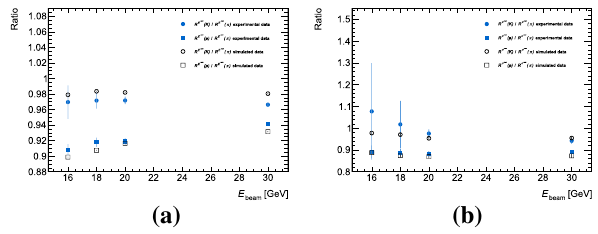
Fig. 22 a Ratios of the kaon and proton responses over those from the pions as a function of E beam . The blue circles (black empty circles) show the ratios R (cid:6) E raw (cid:7) ( K )/ R (cid:6) E raw (cid:7) (π) obtained using experimental (simulated) data. The blue full (black empty) squares show the ratios R (cid:6) E raw (cid:7) ( p )/ R (cid:6) E raw (cid:7) (π) obtained using experimental (simulated) data. b Ratios of the kaon and proton resolutions over those from the pion as a function of E beam . The blue cicles (black empty circles) show the ratios R σ raw ( K )/ R σ raw (π) obtained using experimental (simulated) data. The blue full (black empty) squares show the ratios R σ raw ( p )/ R σ raw (π) obtained using experimental (simulated) data. In the case of experi- mental results uncertainties include statistical and systematic effects combined in quadrature. For simulated results, only statistical uncer- tainties are reported